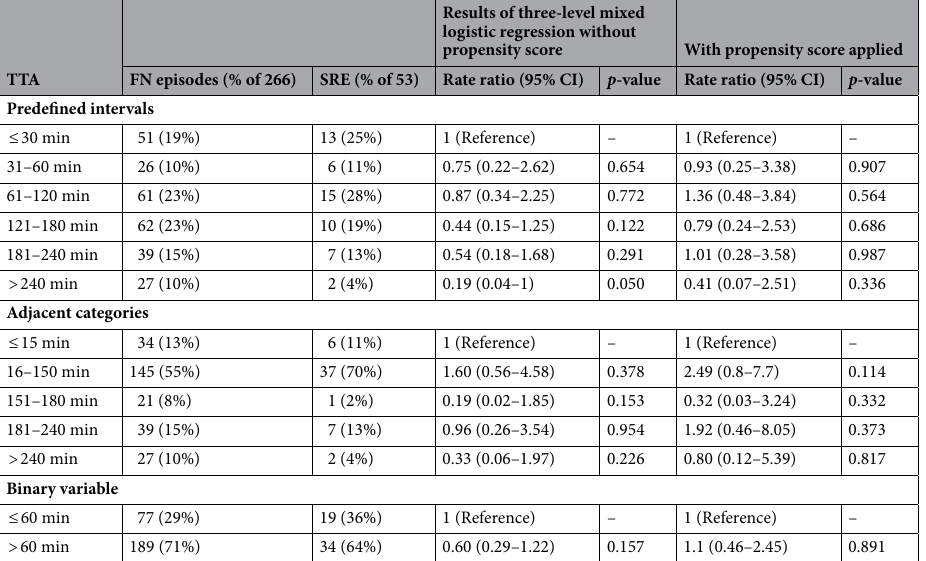
Results of three-level mixed logistic regression without propensity score With propensity score